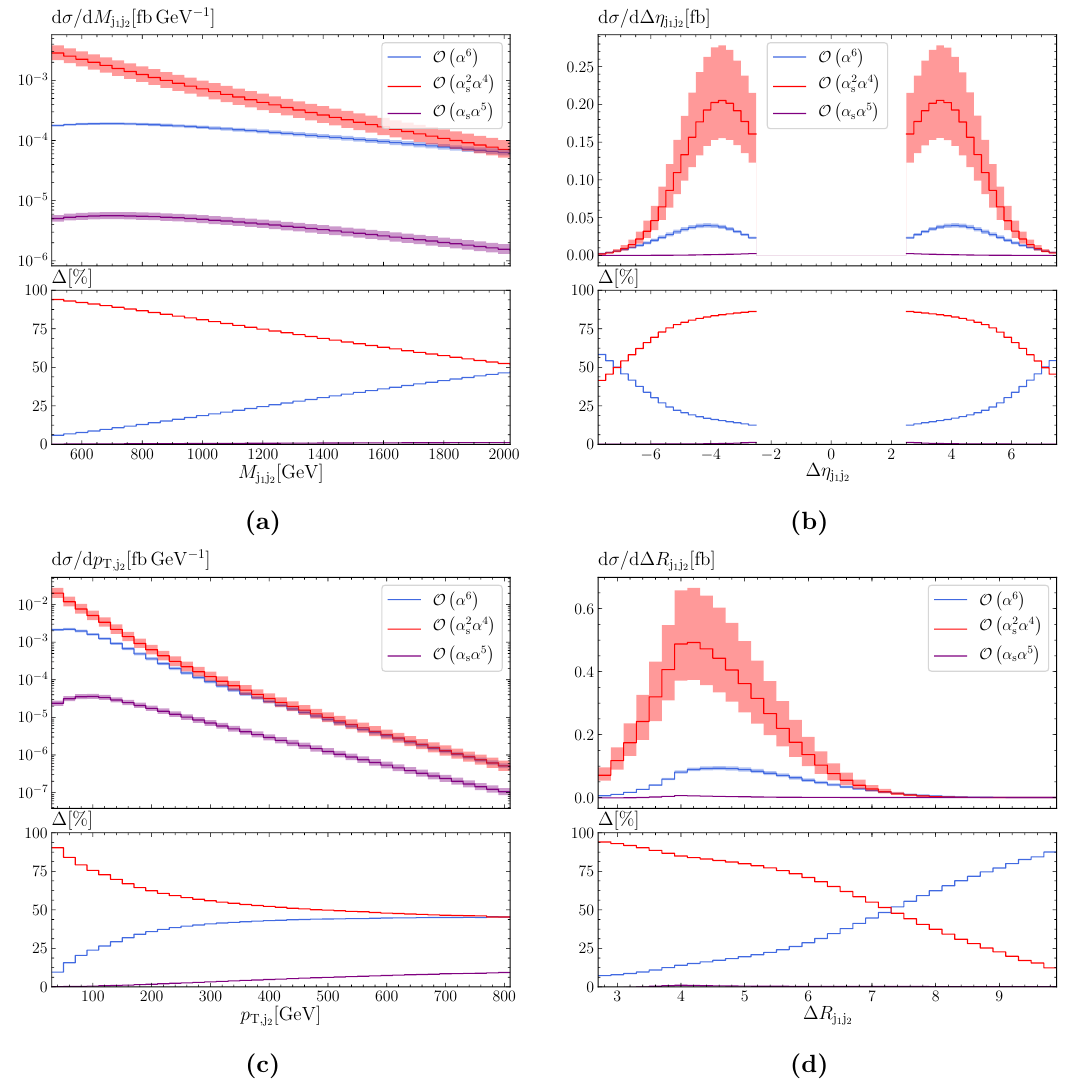
Figure 5. LO di(cid:11)erential distributions for pp (cid:22) + (cid:22) (cid:0) e + (cid:23) e jj + X at the LHC with CM energy ! 13 TeV: (a) invariant mass of the two jets (top left), (b) di(cid:11)erence of pseudo-rapidity of the two jets (top right), (c) transverse momentum of the second hardest jet (bottom left), and (d) rapidity- azimuthal-angle distance between the two jets (bottom right). The upper panel shows the absolute contributions of order (QCD). The bands O denote the envelope of the scale variation for each order. The lower panel shows the relative LO contributions (cid:1) to their sum in